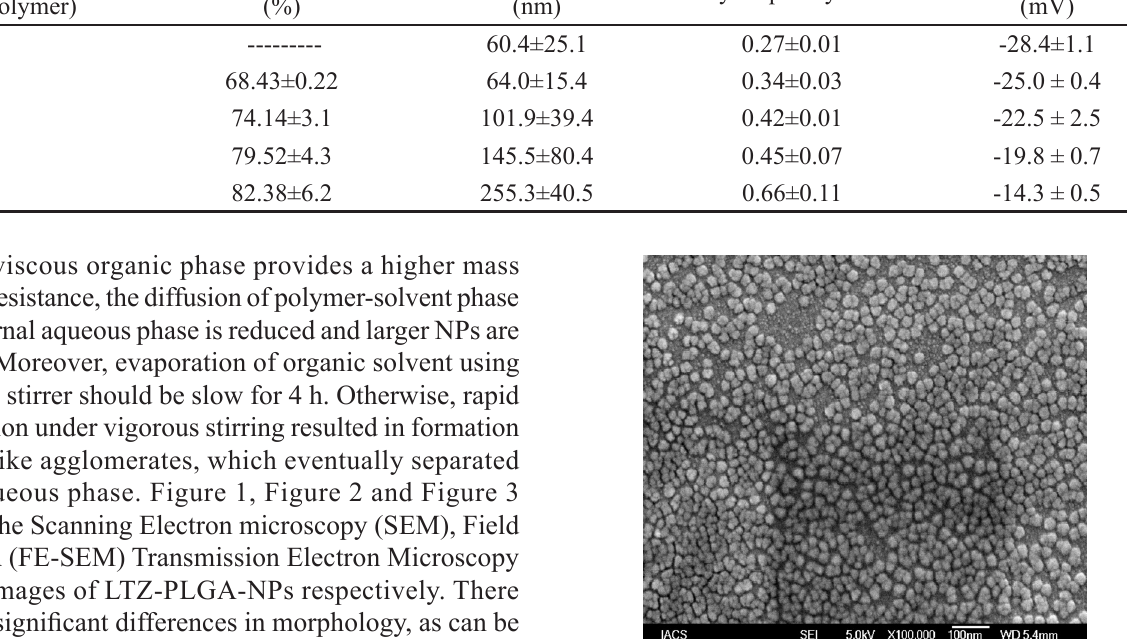
TABLE I. Characterization of blank NPs and LTZ-PLGA-NPs Formulation Drug (wt% of polymer)